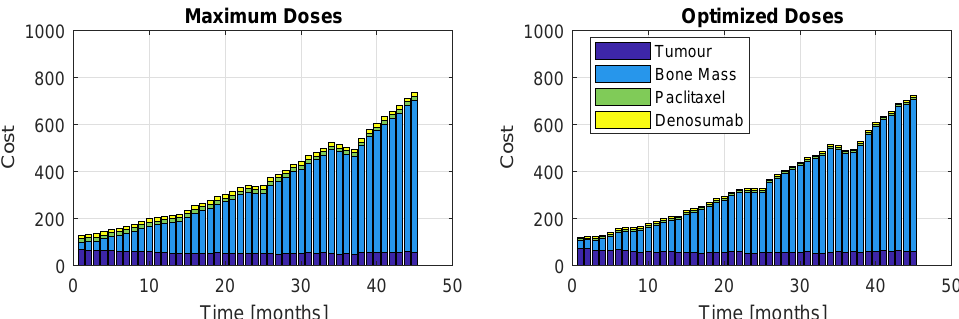
Figure 15. Proportions of the four cost contributions/terms in the objective function: Tumour, Bone Mass, Paclitaxel and PI (Model M DR 1 , Therapy T 4 + T 3 ). The right plot represents the cost resultant from optimization, while the left represents the cost if the maximum dose was administrated.